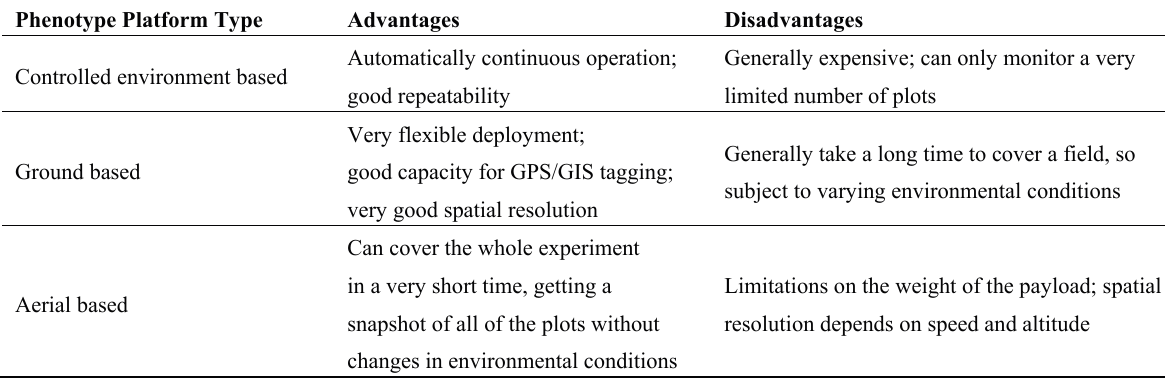
Table 3. Relative advantages and disadvantages about typical phenotyping platforms